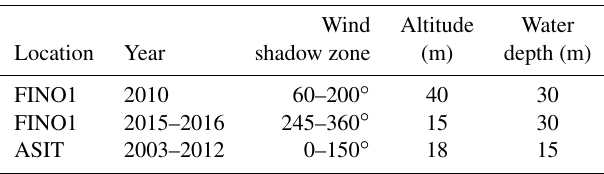
Wind Altitude Water